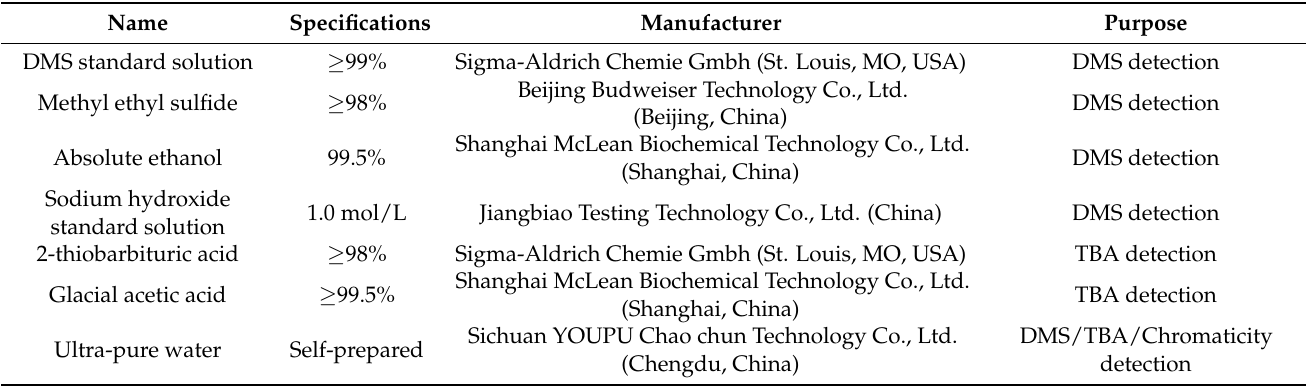
Table 1. Test reagent required for the